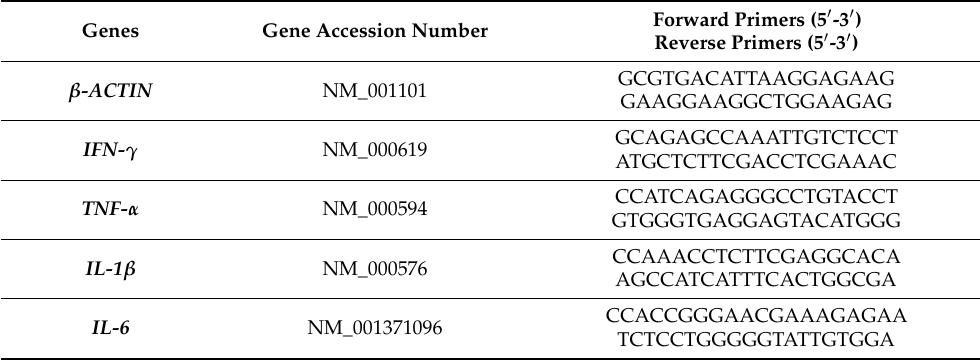
Table 2. List of genes and their respective forward and reverse